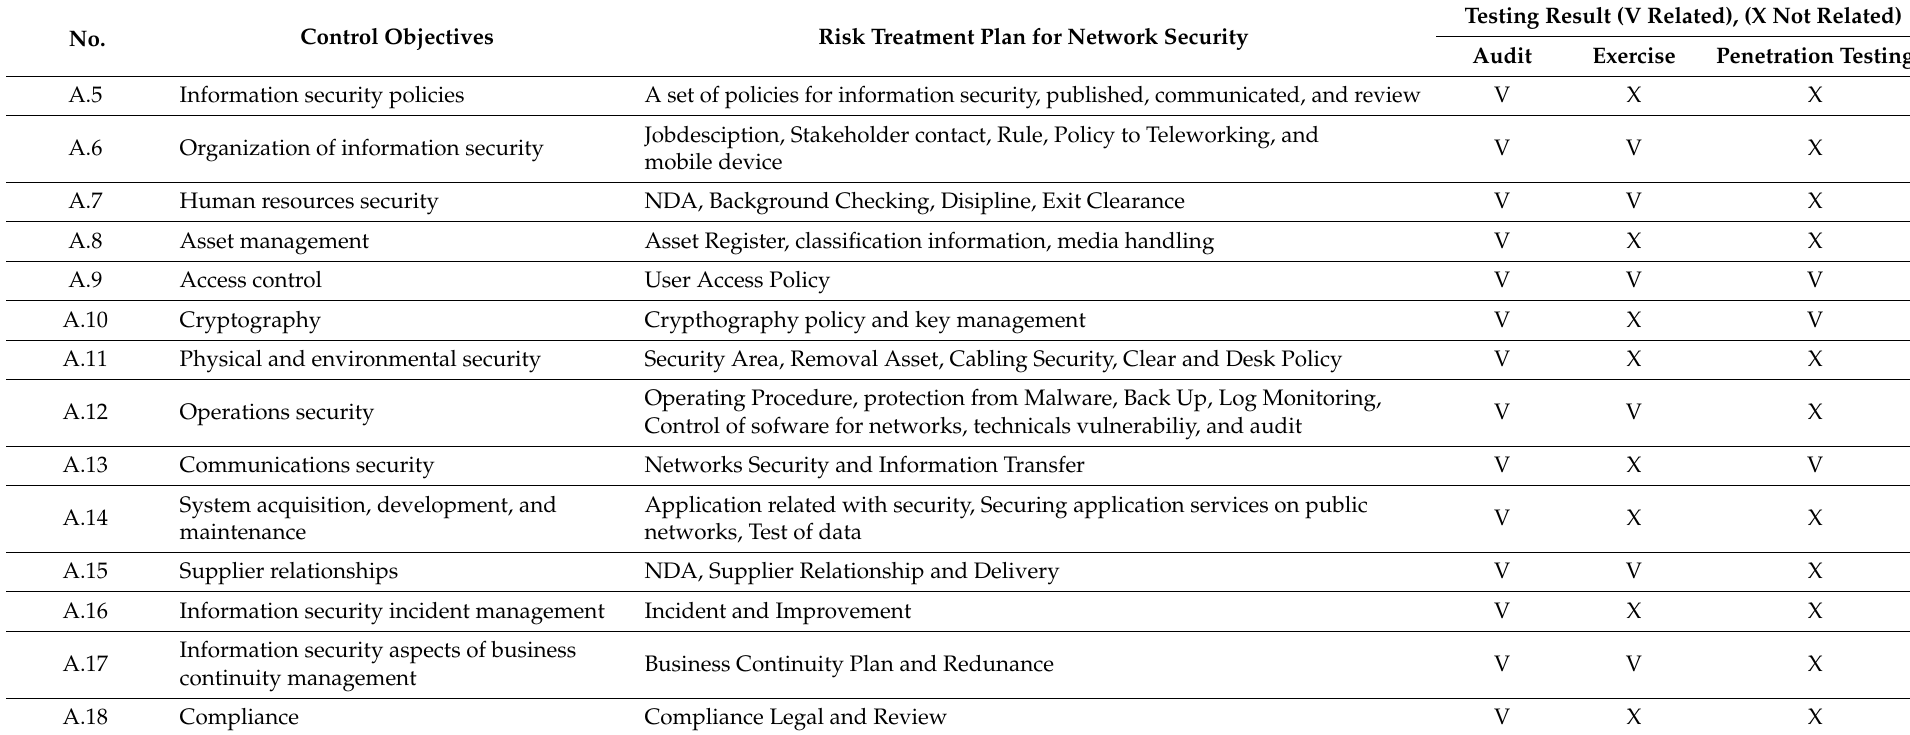
Table A2. Mapping the Relationship between Risk Treatment Plan Control with Testing